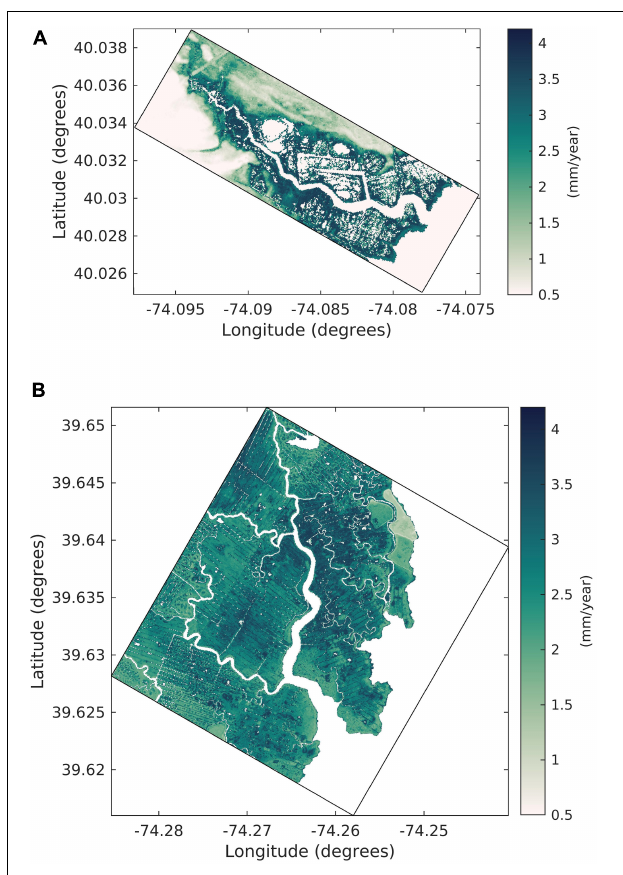
FIGURE 9 | Vertical growth rate due to biomass productivity at the end of the simulation (A) Reedy Creek and (B) Dinner Creek domain.